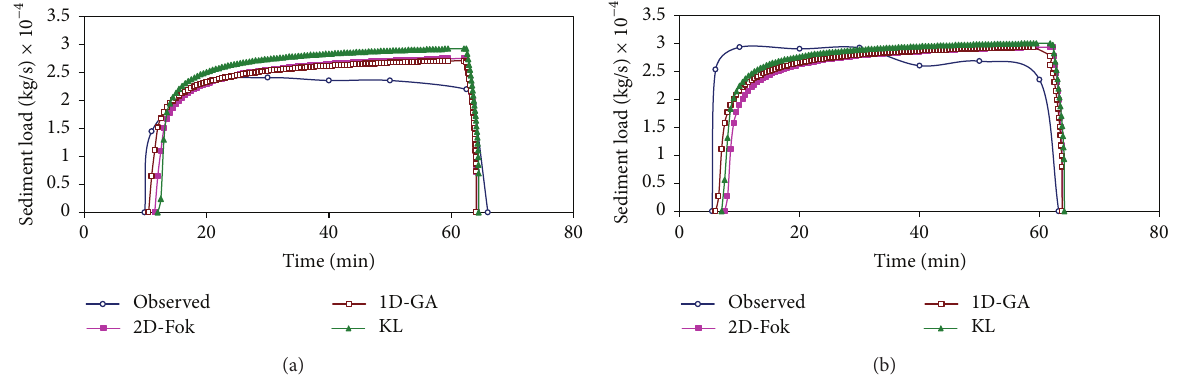
Figure 5: Comparison of observed and simulated sediment load (using MYE) for (a) 16th May 2005 and (b) 30th March 2005 irrigation